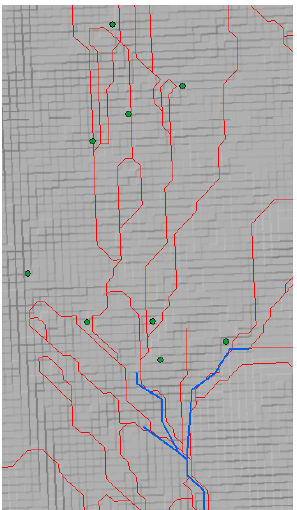
Figure 7: Field points acquired along real streams with thalwegs (red) and streams (blue) from box 1 of Figure 5 Hence thalwegs can represent relevant streams that were lost oth- erwise. These streams mainly correspond to ephemeral or inter- mittent streams whose flow accumulation is low or are located in humid zones where the position of the stream is difficult to